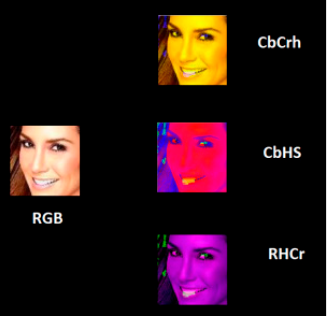
Figure 7. Face image color channel recombination.